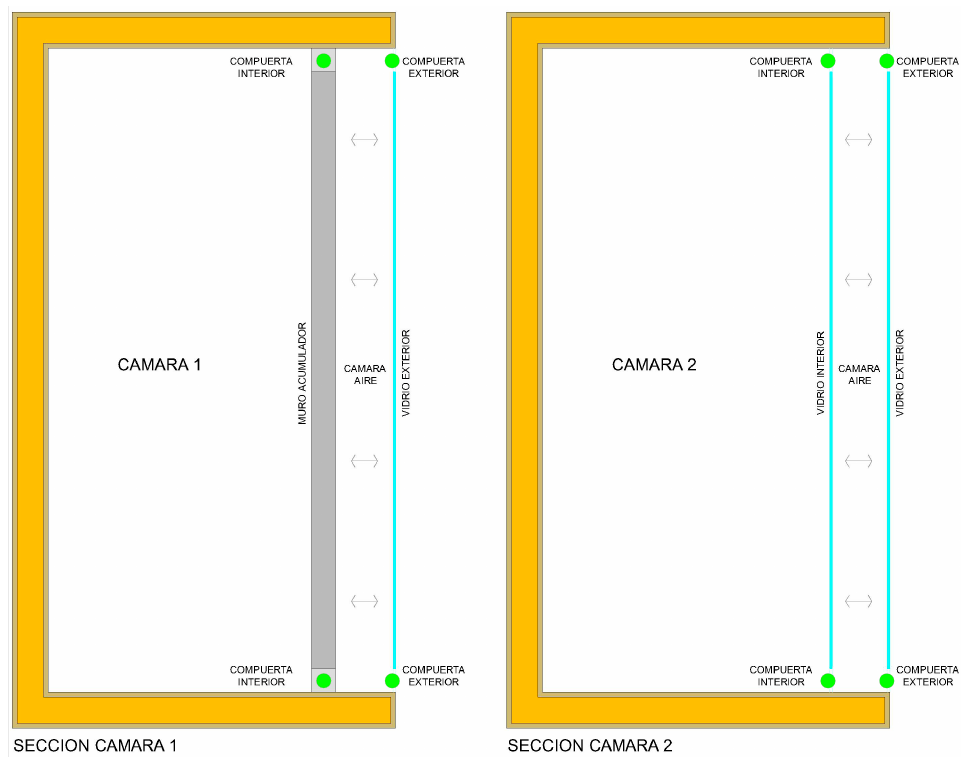
Figure 6. Distribution of the anemometers. The SECCIÓN CAMARA (section or room 1, on the left and 2, on the right) shows the section of the two rooms with the location of the anemometers, i.e., green dots.